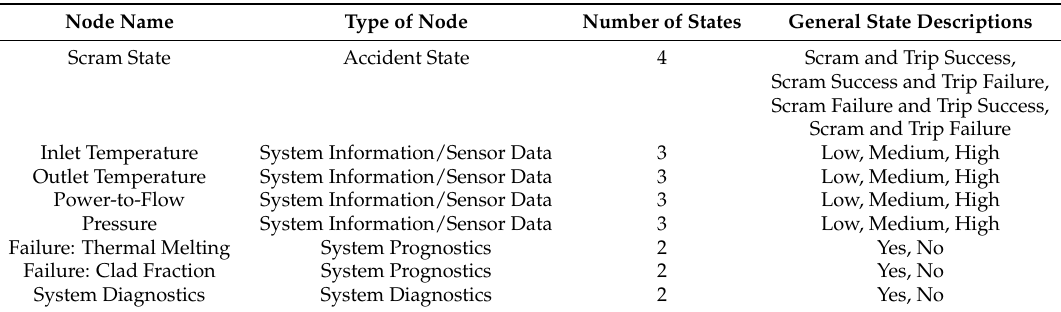
Figure A1. DBN node structure and relationship graph for the SFR TOP case study. The dashed boxes represent the different node regions for the diagnostics and prognostics model for CES. The arrows are reflective on the current time step, with the exception of the dynamic relationship in the nodes in the “System Information/Sensor Data” box. Table A1. Model nodes and node